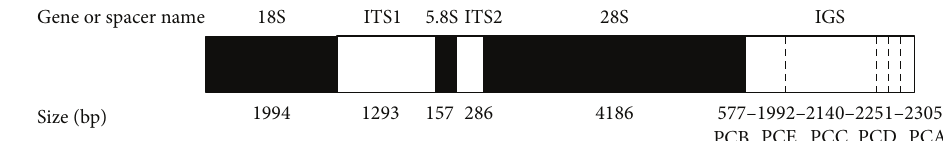
Figure 1: Organization of rRNA genes and spacers in Paramphistomum cervi . Dark shading indicates genes, light shading indicates spacers, and dashed bars in spacers indicate five lengths of IGS sequences.